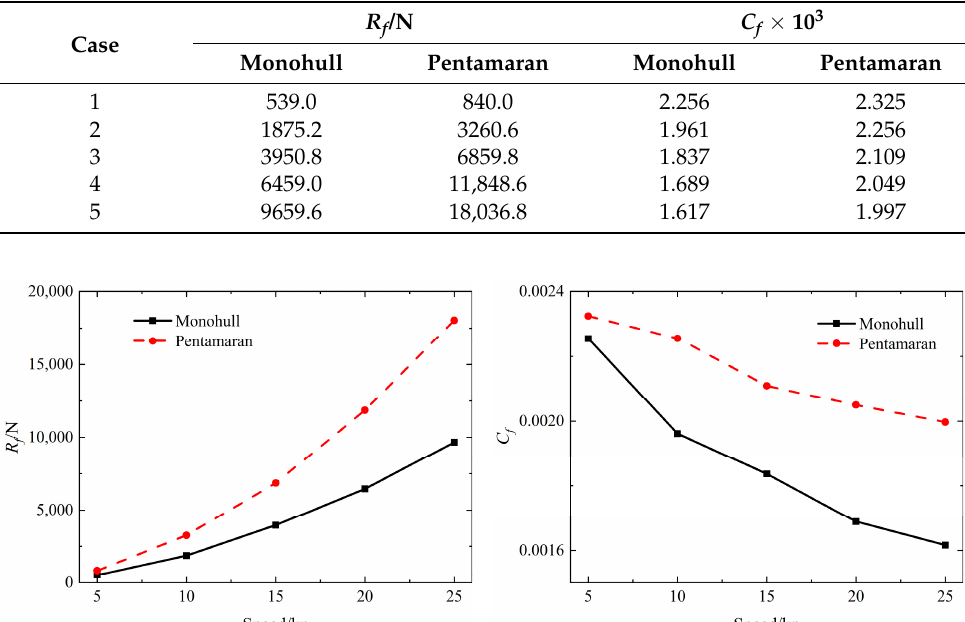
Table 10. Calculation results of pressure resistance.